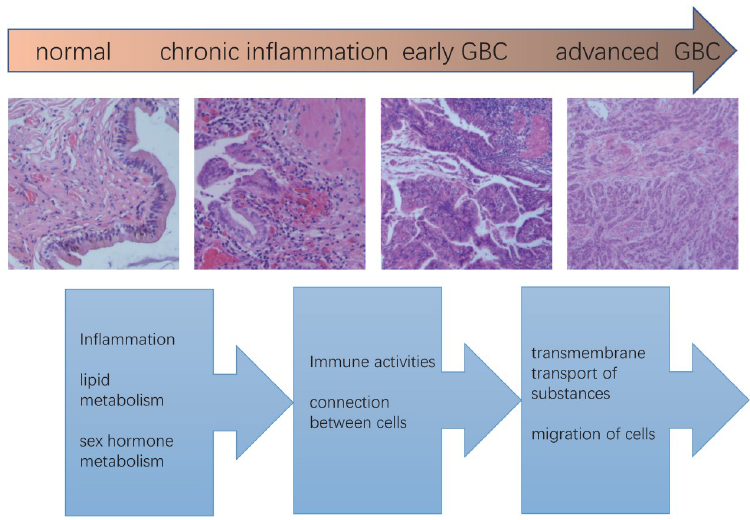
Fig 8. Schematic diagram of the multi-stage development of GBC. The top arrow indicates the four stages in the development of GBC. The four pictures in the middle were taken from typical pictures of each stage from our specimens. The text below indicates the prominent gene expression changes during the phase